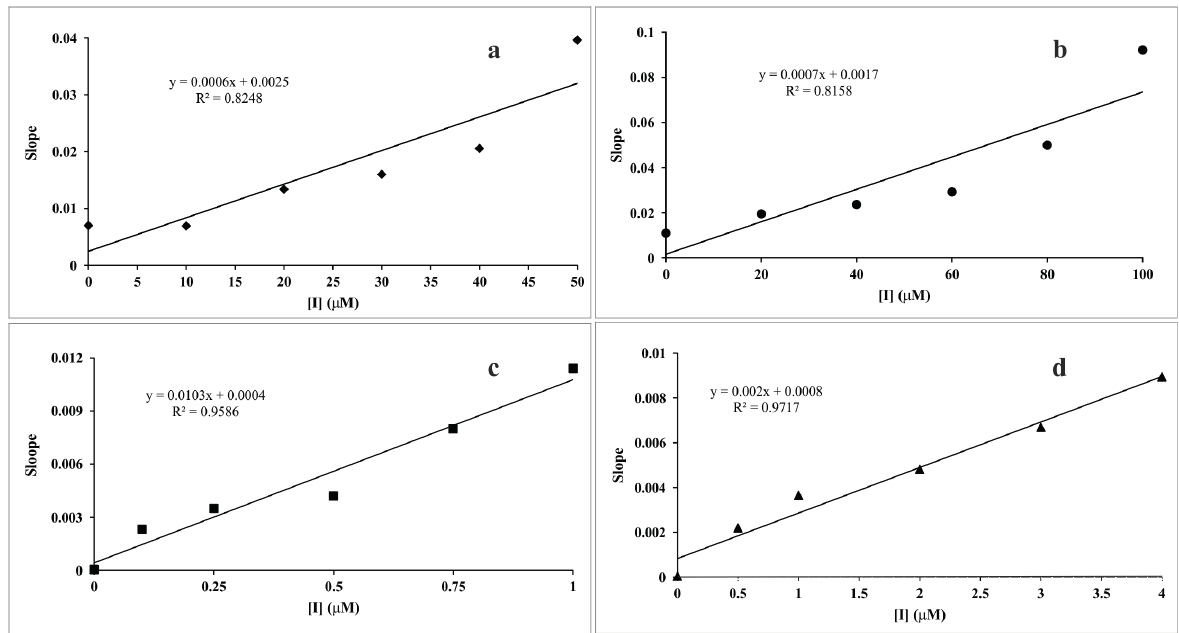
Figure 4. Graphic slopes of the Lineweaver-Burk graphic versus concentration of I for the hydrolysis of L-BApNA by partially purifi ed trypsin- like in the presence of the inhibitors ( a ) benzamidine, ( b ) berenil, ( c ) SKTI and ( d ) SBBI.